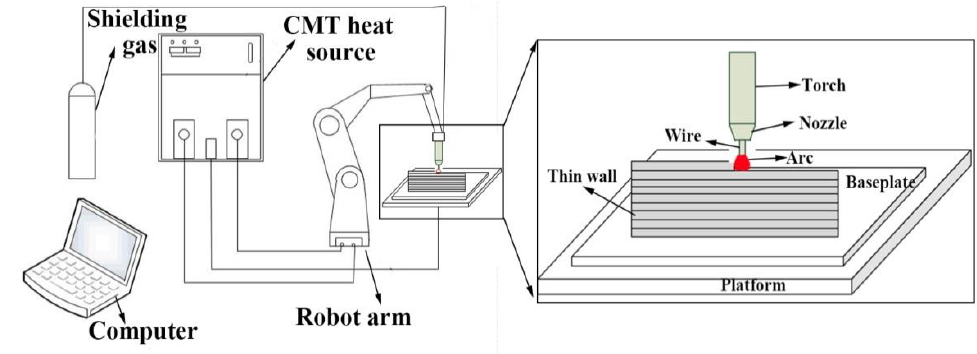
Figure 2. Schematic description of the CMT-based WAAM system. Table 1. Chemical composition of ER316L stainless steel wire. Table 2. Processing parameters of WAAM used in this study. LEI: linear energy input.